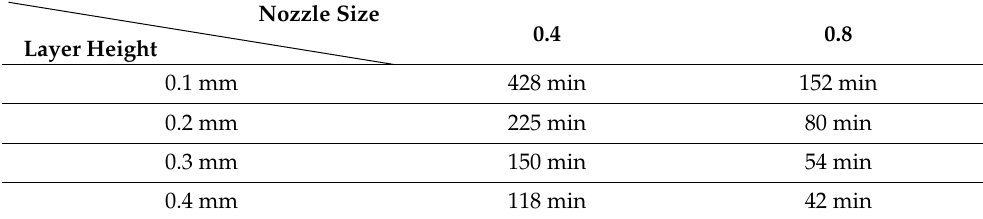
Table 2. Shielding sheet manufacturing time using a 3D printer.